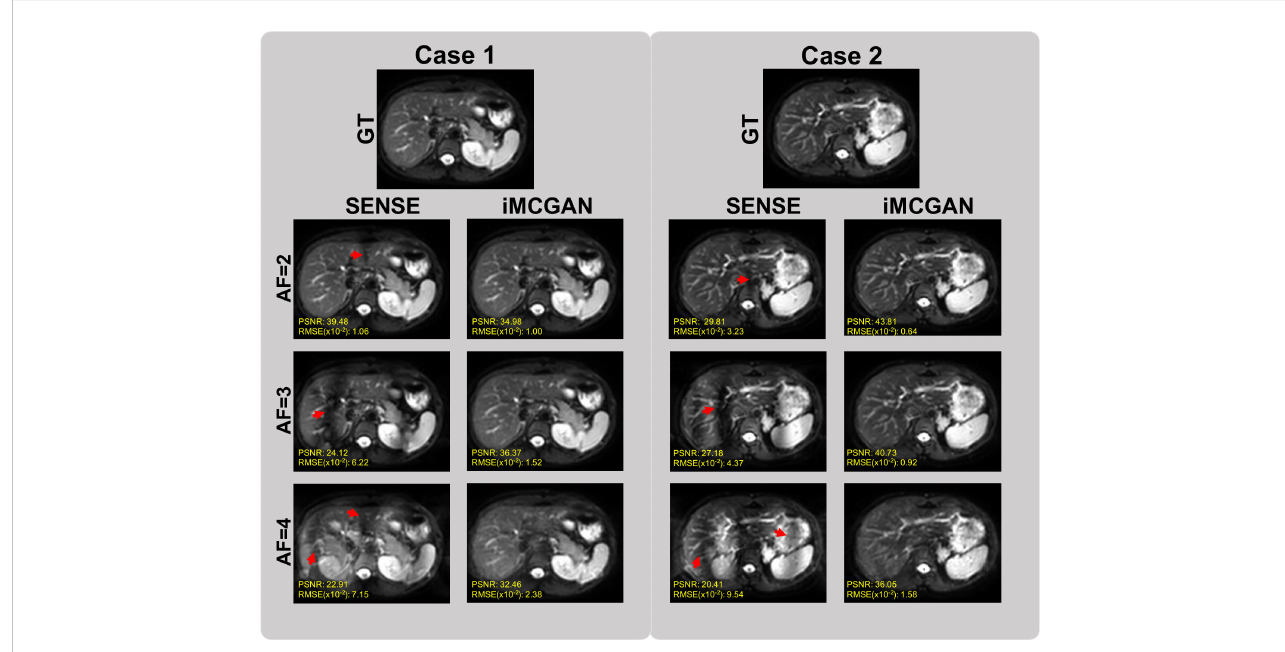
FIGURE 9 The comparisons between the SENSE and iMCGAN reconstructions with the Afs of 2, 3, and 4. All images reconstructed with the proposed iMCGAN were free of aliasing